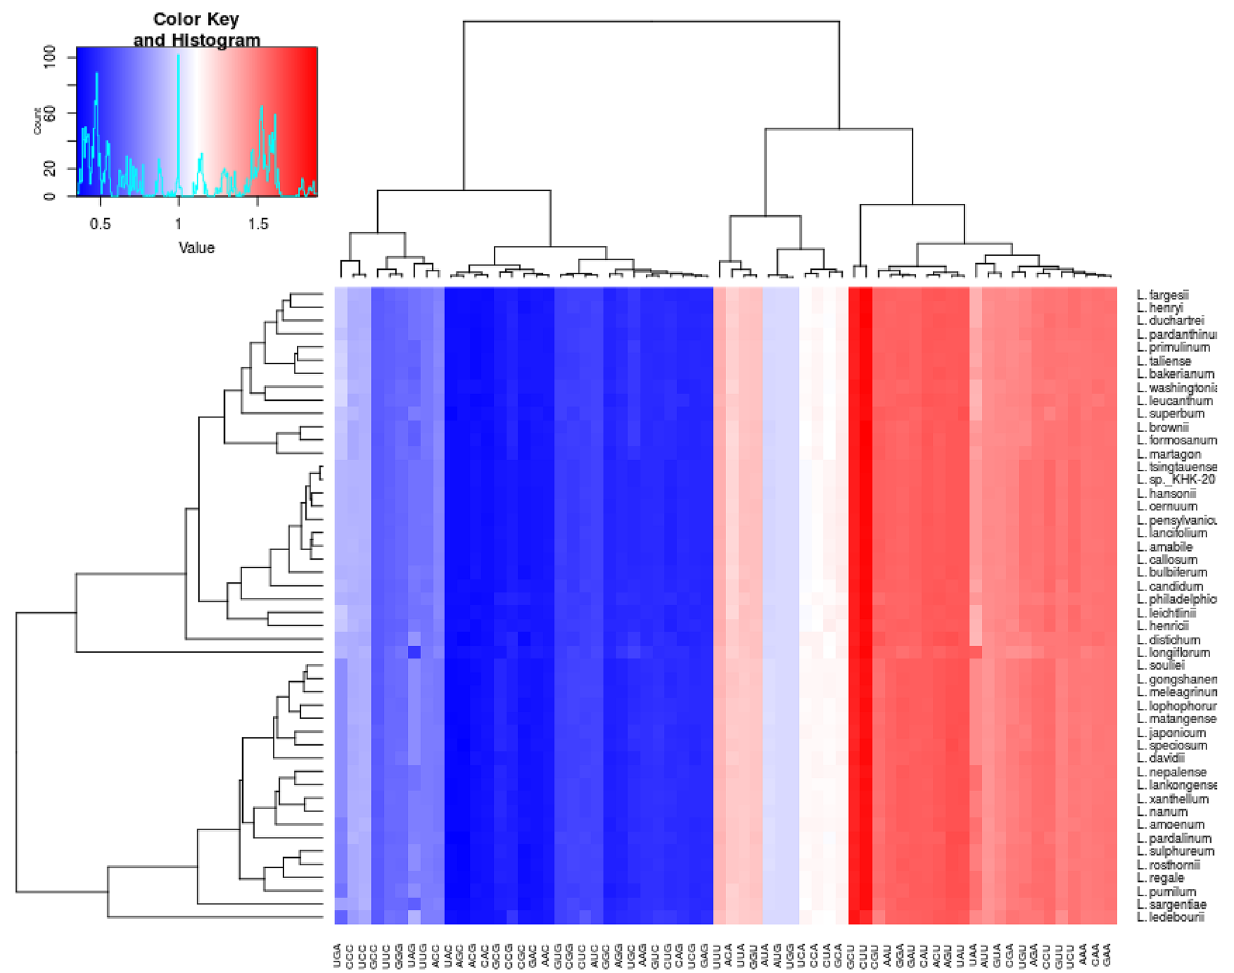
Figure 5. Codon distribution of protein-coding genes among Lilium cp genomes. Color code: Red denotes a higher RSCU and blue denotes a lower